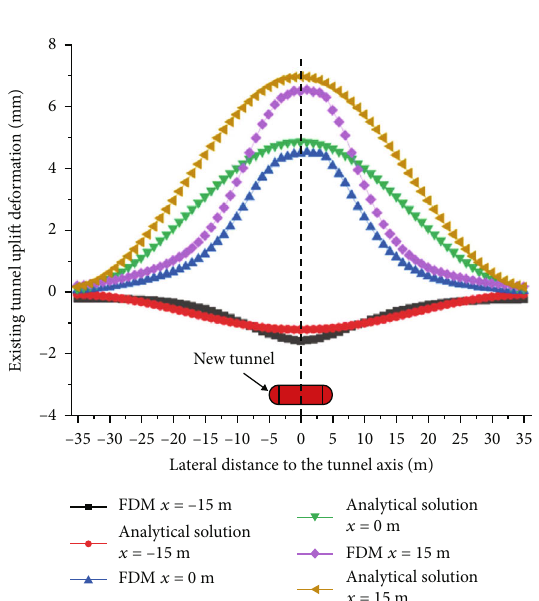
Figure 13: Subsidence curve.